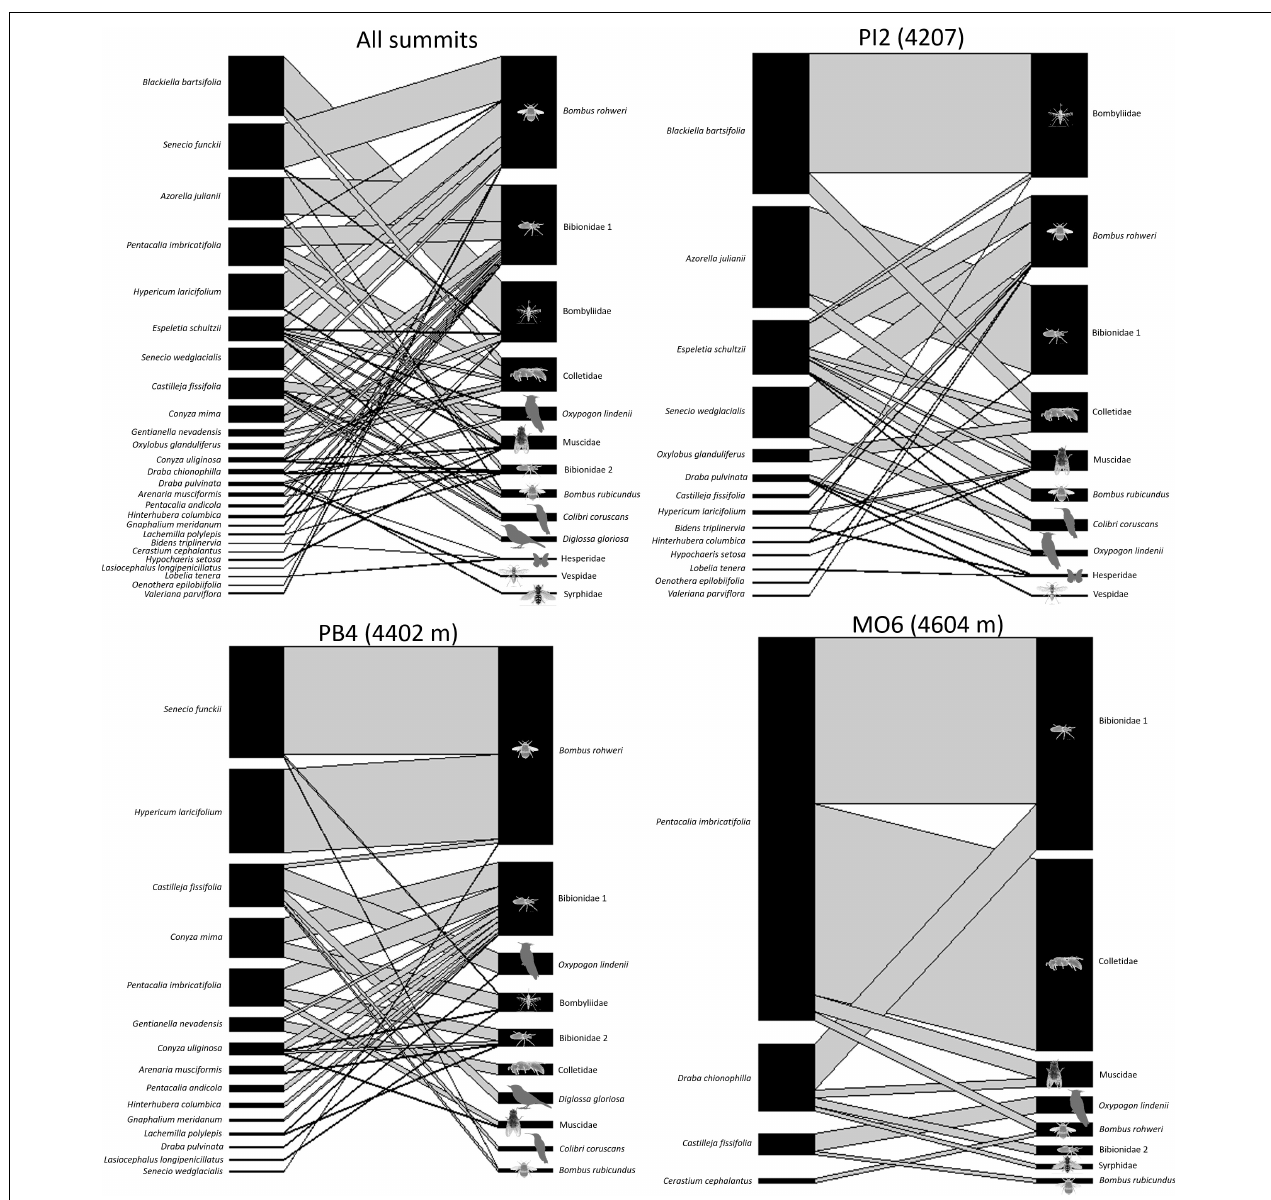
FIGURE 5 | Plant–pollinator networks of the GLORIA–Andes network (VE-CPB site), at La Culata National Park, Piedras Blancas Páramo, Venezuela. The thickness of the links represents the total intensity of the interaction (visitation frequency). The size of the rectangles represents the relative importance of the species in the network (in terms of the number and intensity of its interactions with other